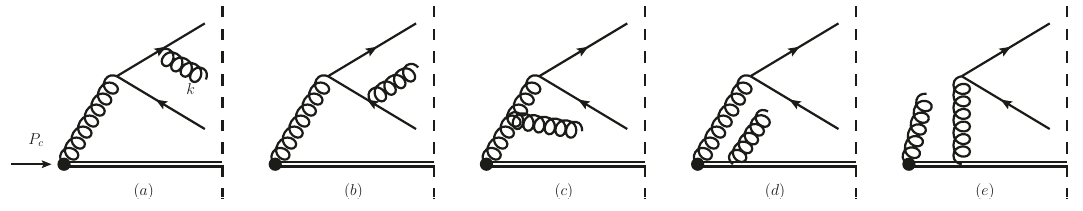
Figure 6 . Feynman diagrams for real correction of the fragmentation function at